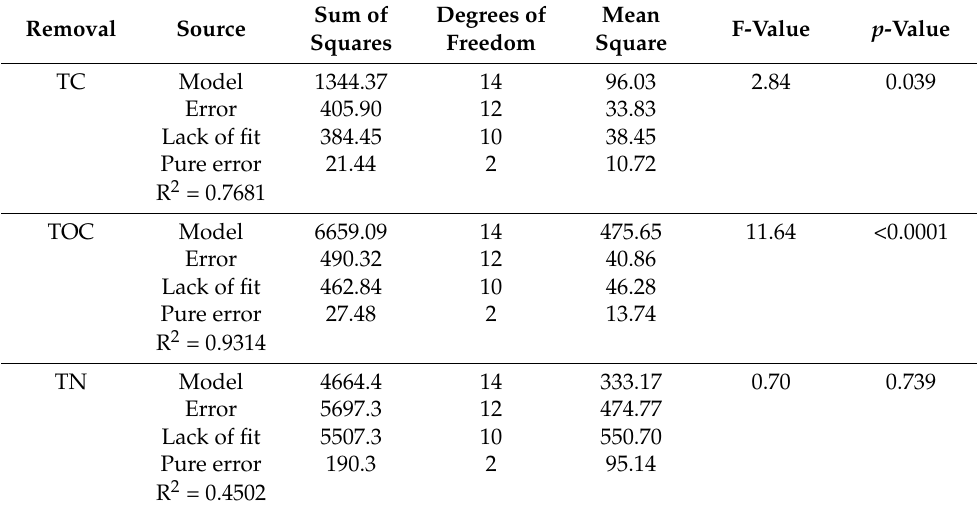
Table 2. ANOVA results of the quadratic polynomial model for the photo-Fenton-like process of municipal